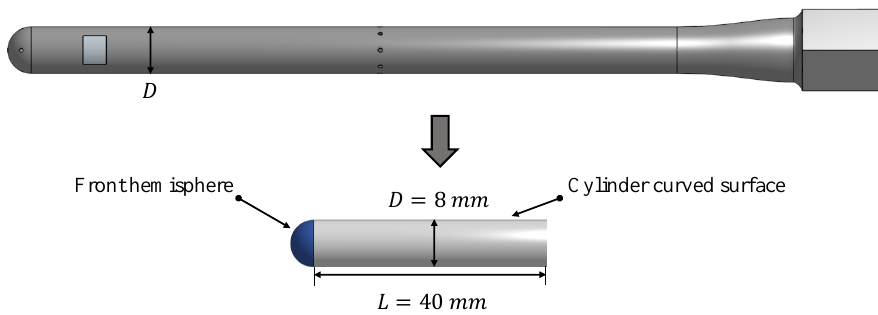
Figure 2. Probe geometry transformation for the definition of the analytical